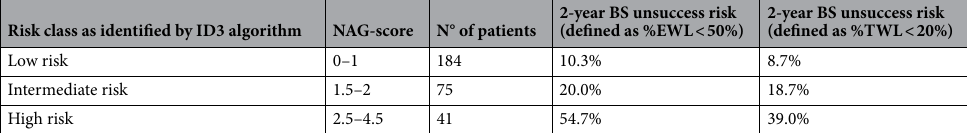
Risk class as identified by ID3